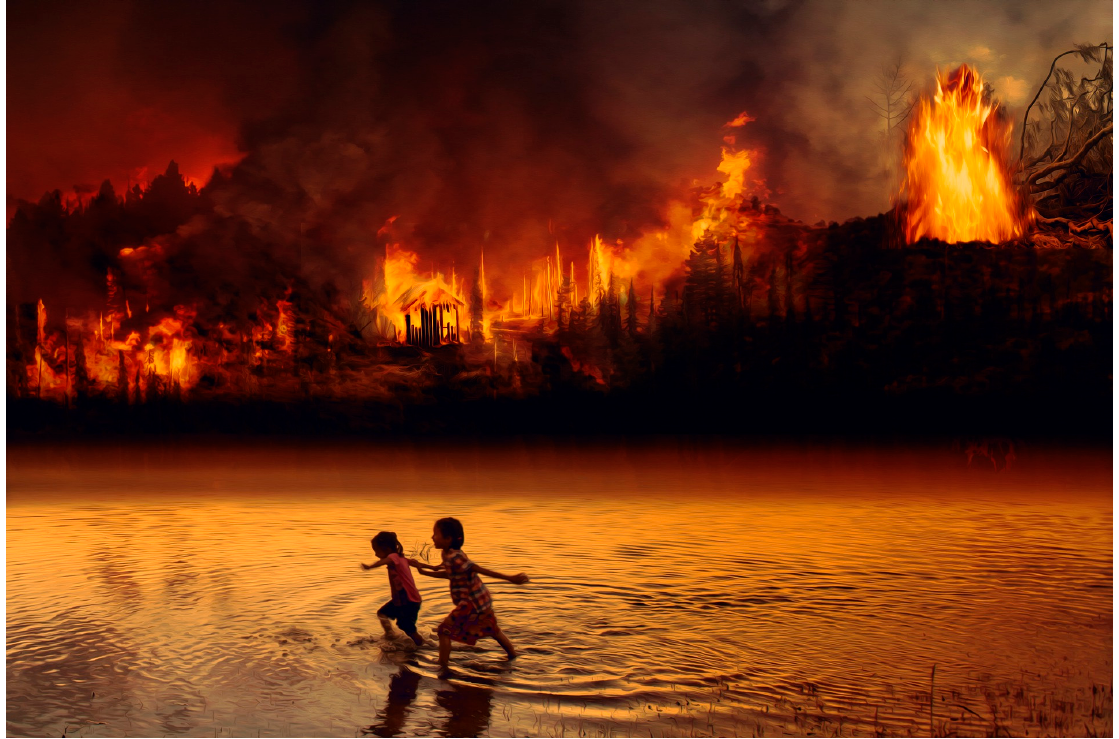
Figure 17. A snapshot from August 2019 Amazon rainforest fires [74].